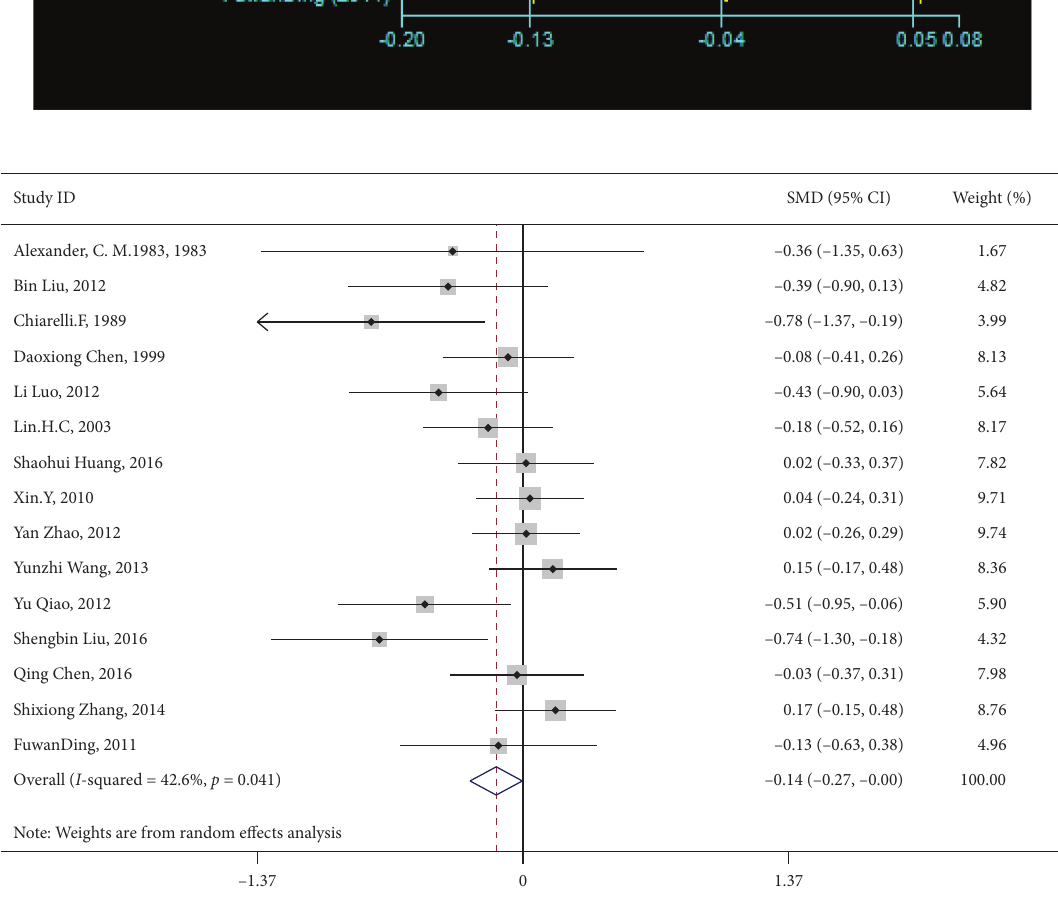
Figure 3: Sensitivity analysis of